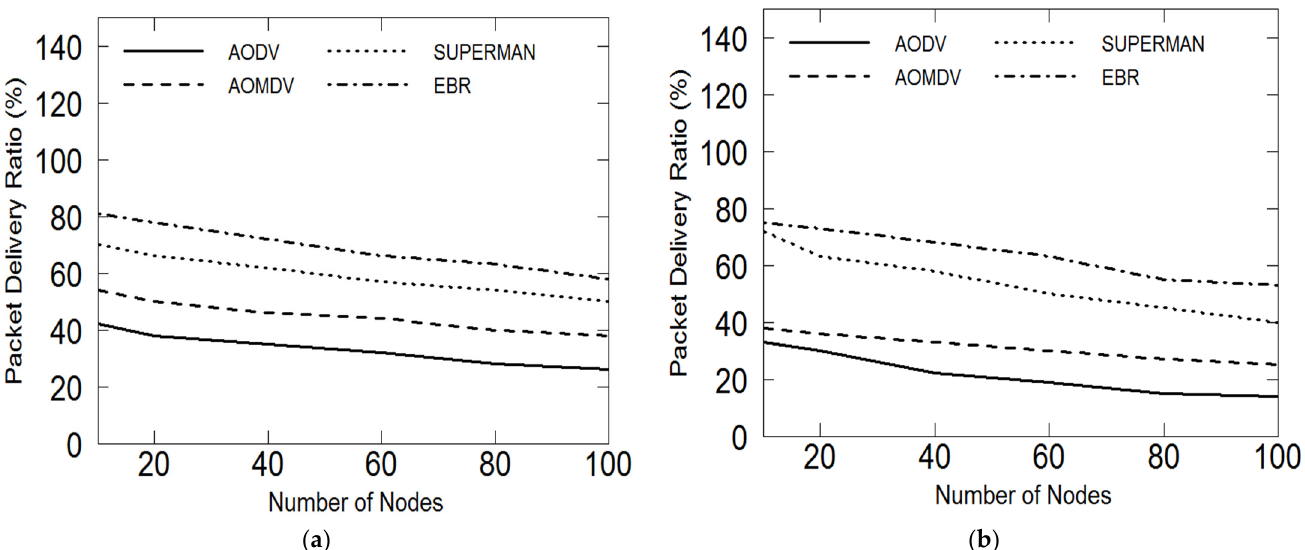
Figure 5. ( a ) PDR vs. number of nodes (without attack); ( b ) PDR vs. number of nodes (with attack).